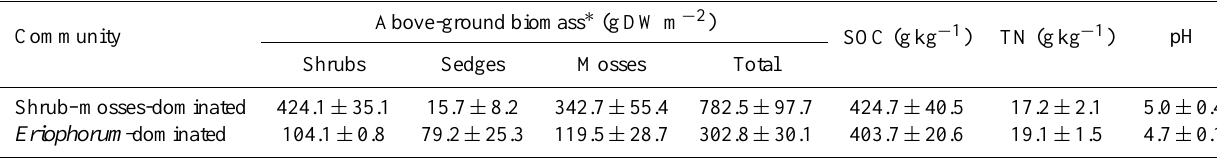
Table 1. Above-ground biomass and the main chemical characteristics of the soils (0–20cm depth) from the shrub–moss-dominated com- munity and Eriophorum -dominated community. Values represent the mean and the standard deviation ( n = 3). Community